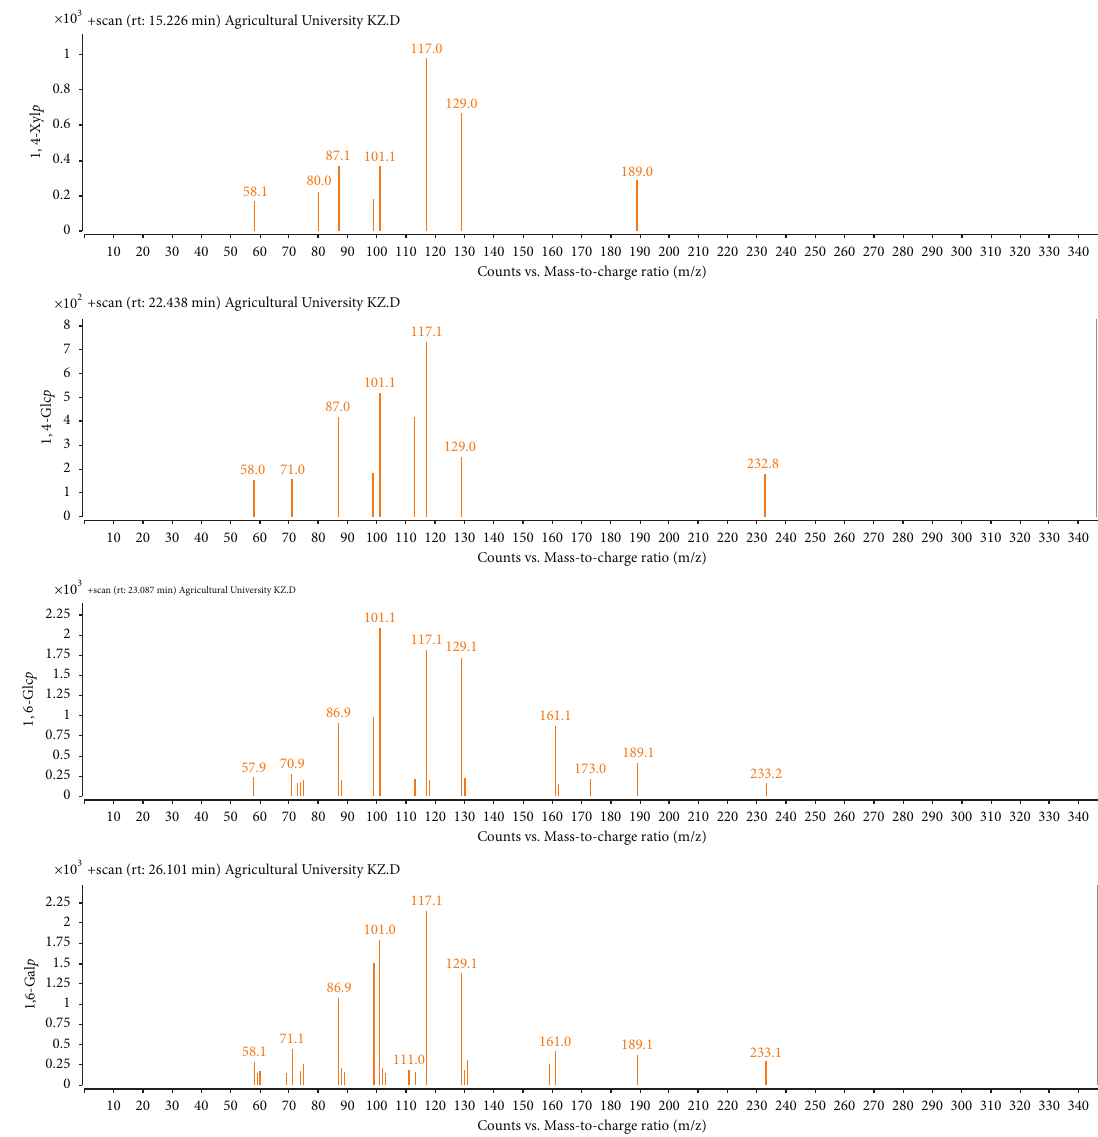
Figure 6: Ion fragments corresponding to each